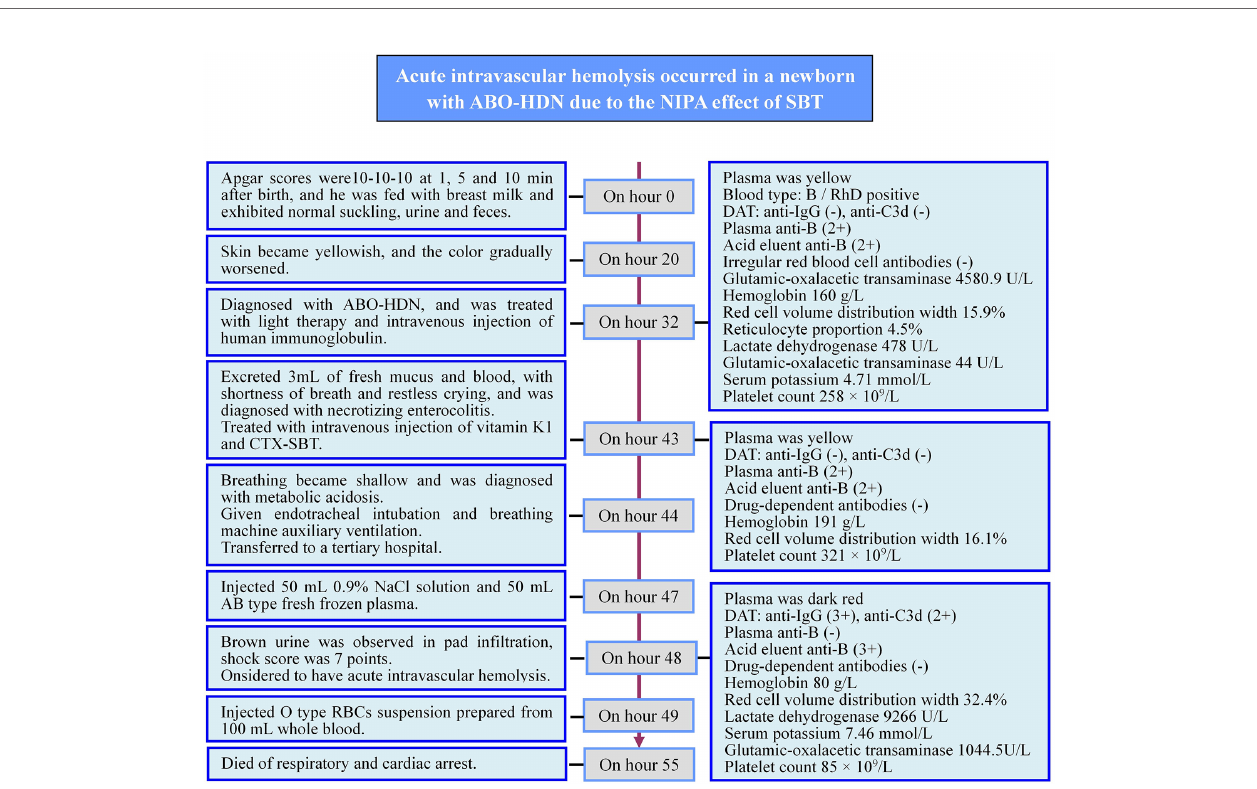
FIGURE 1 | Timeline of the newborn disease process. ABO-HDN, ABO blood type incompatibility hemolytic disease of newborn; DAT, direct antiglobulin test; CTX-SBT, cefotaxime sodium - sulbactam sodium